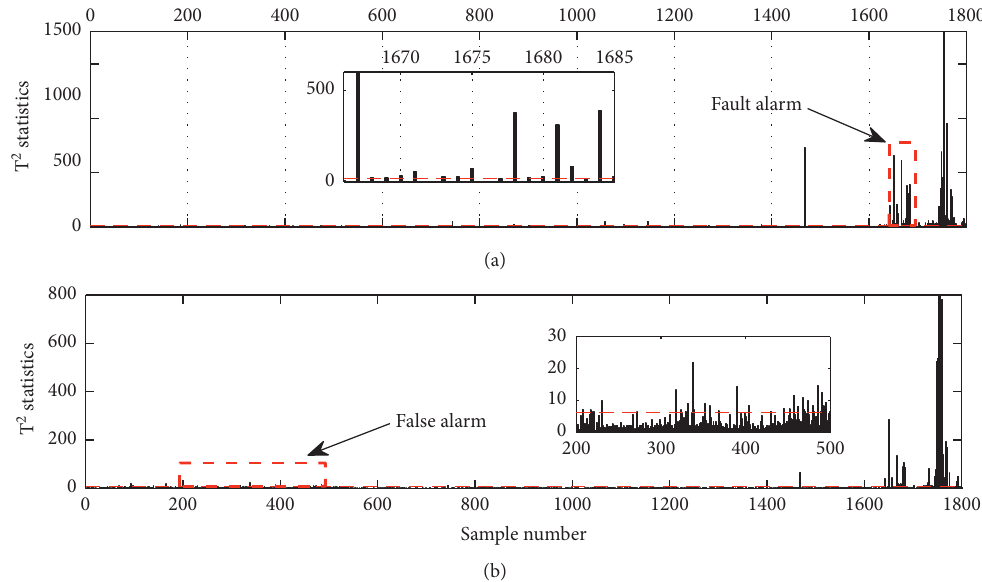
Figure 15: (a) An improved dual-kurtogram-based T 2 control chart. The redline is UCL of 17.82. (b) Conventional Hotelling’s T 2 control chart. The redline is UCL of 6.69.